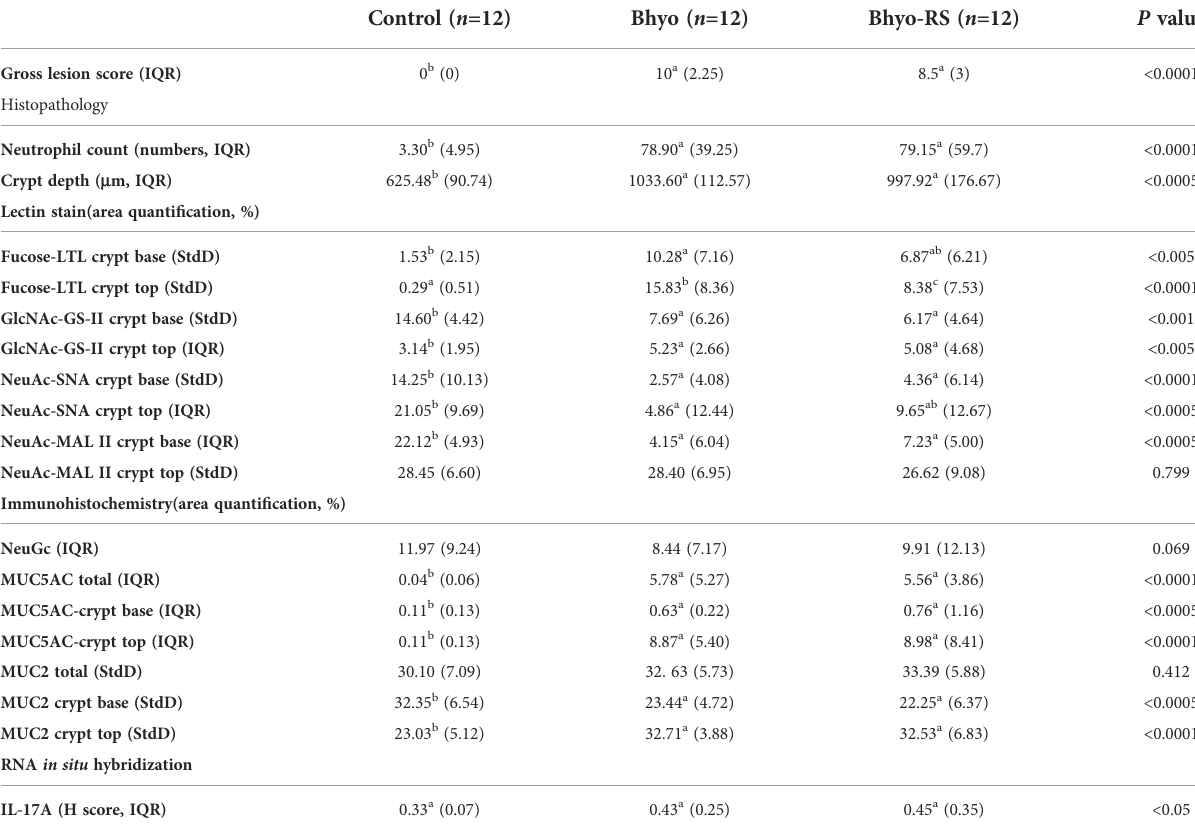
TABLE 1 Histopathologic fi ndings in pigs with and without swine dysentery after Brachyspira hyodysenteriae infection and fed a diet containing sugar beet pulp and resistant starch diet in one of the inoculated groups. Control ( n